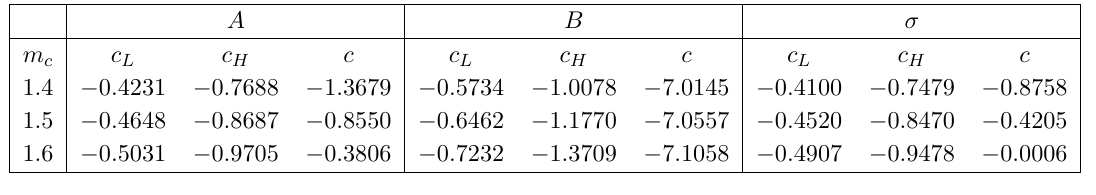
Table 4 . The coefficients c L , c H , and c for e + e − → J/ψ + χ c 2 at is GeV.